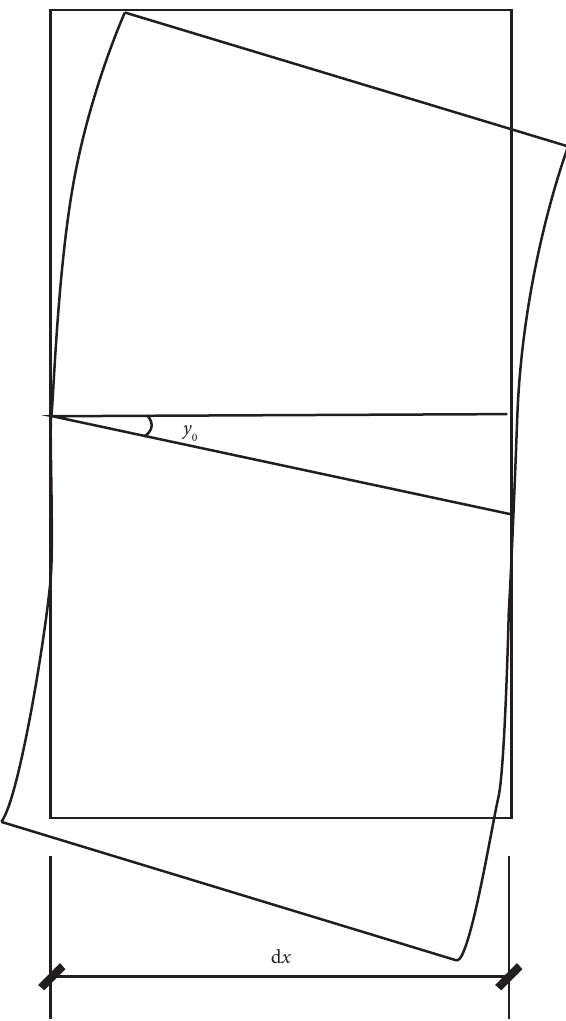
Figure 21: Shear deformation of the element of sandwich